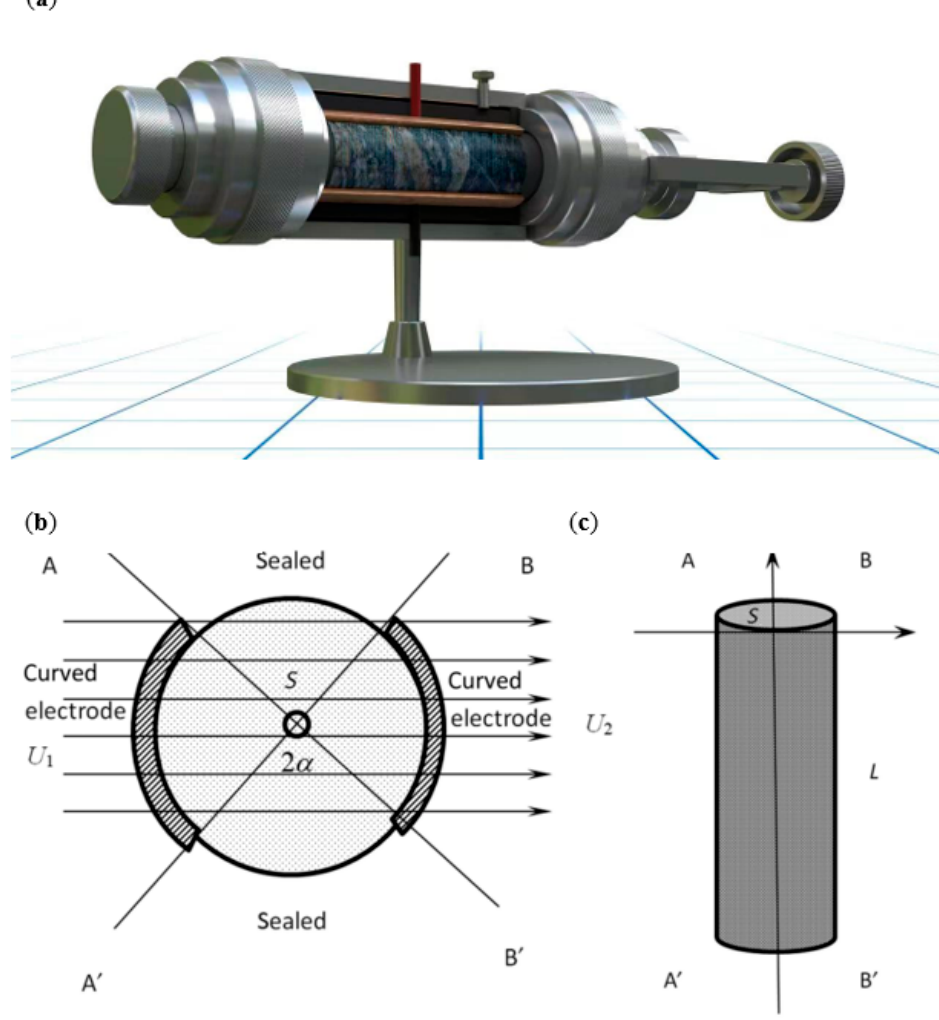
Figure 1. Radial resistivity testing method: ( a ) experimental device; ( b ) top view of cylindrical core; ( c ) cylindrical core.